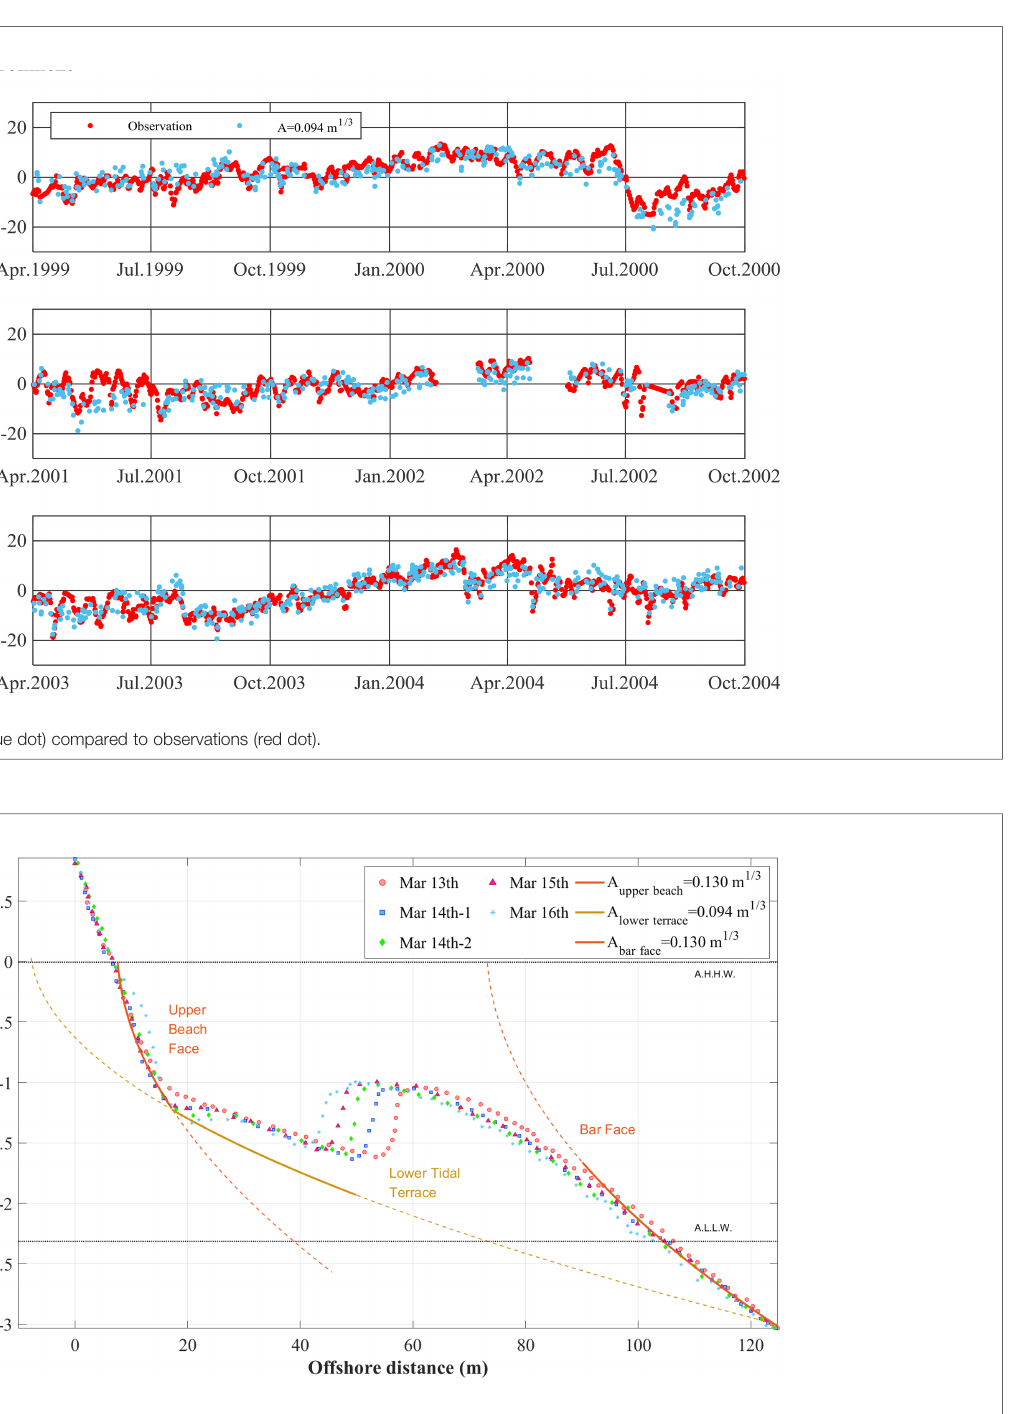
FIGURE 11 | Equilibrium beach pro fi le for estimating the beach scale